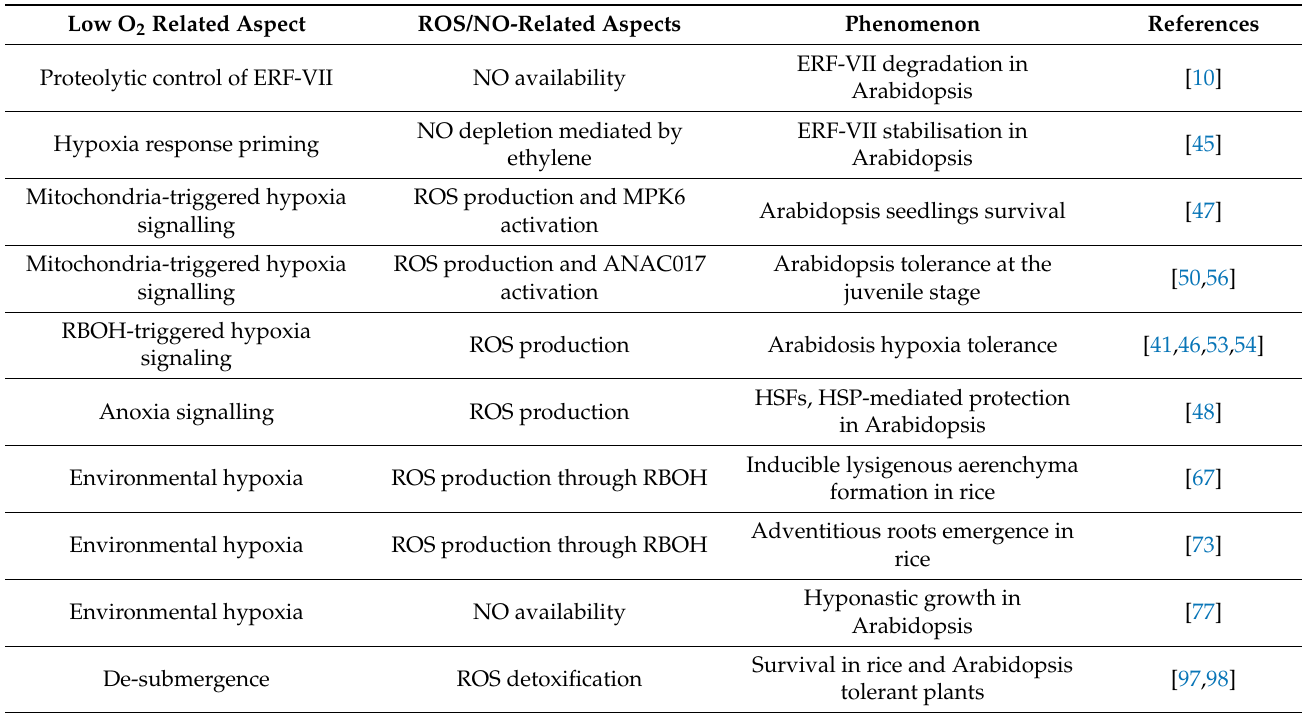
Table 1. Reactive oxygen species (ROS) and nitric oxide (NO) involvement in low oxygen (O 2 ) Arabidopsis and rice adaptation